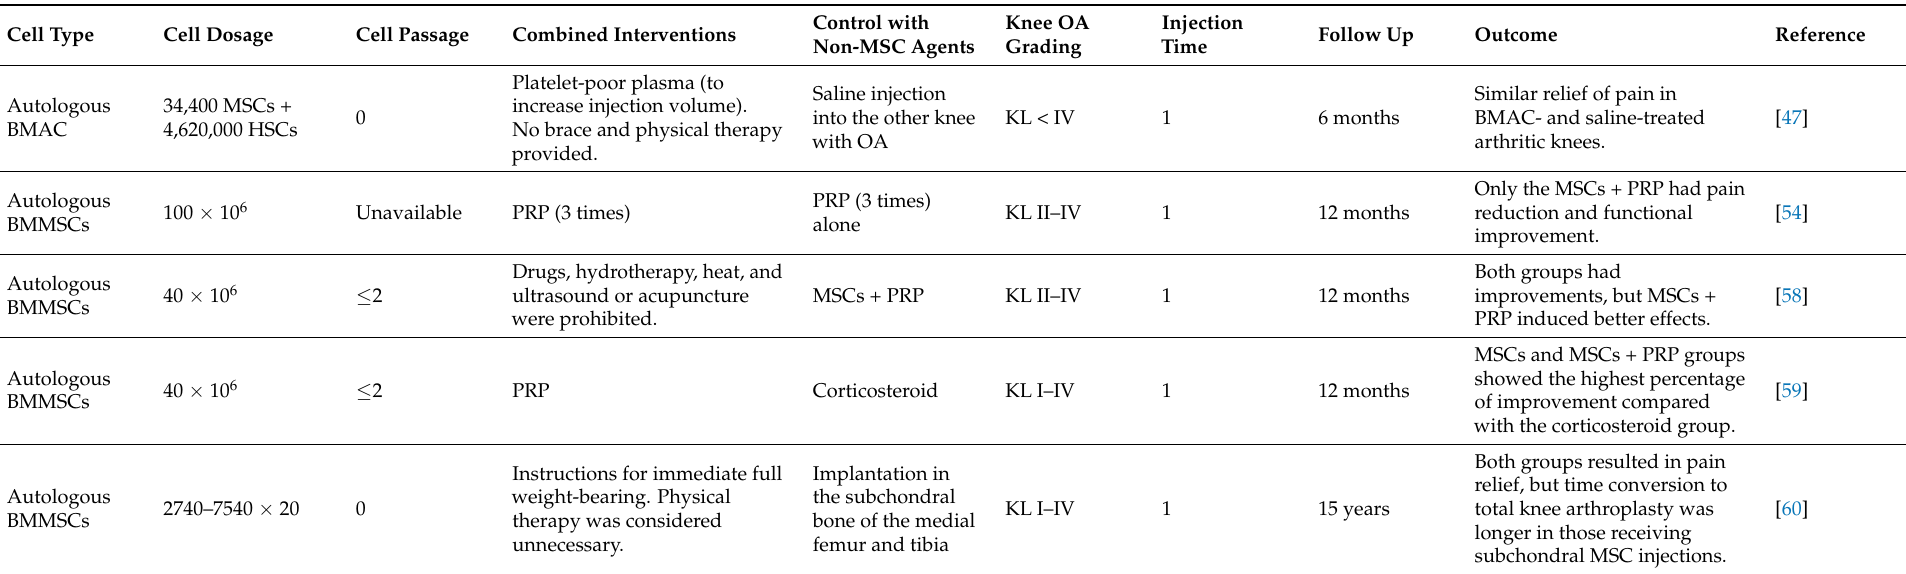
Table 2. Substance comparison injection studies using autologous bone marrow-derived